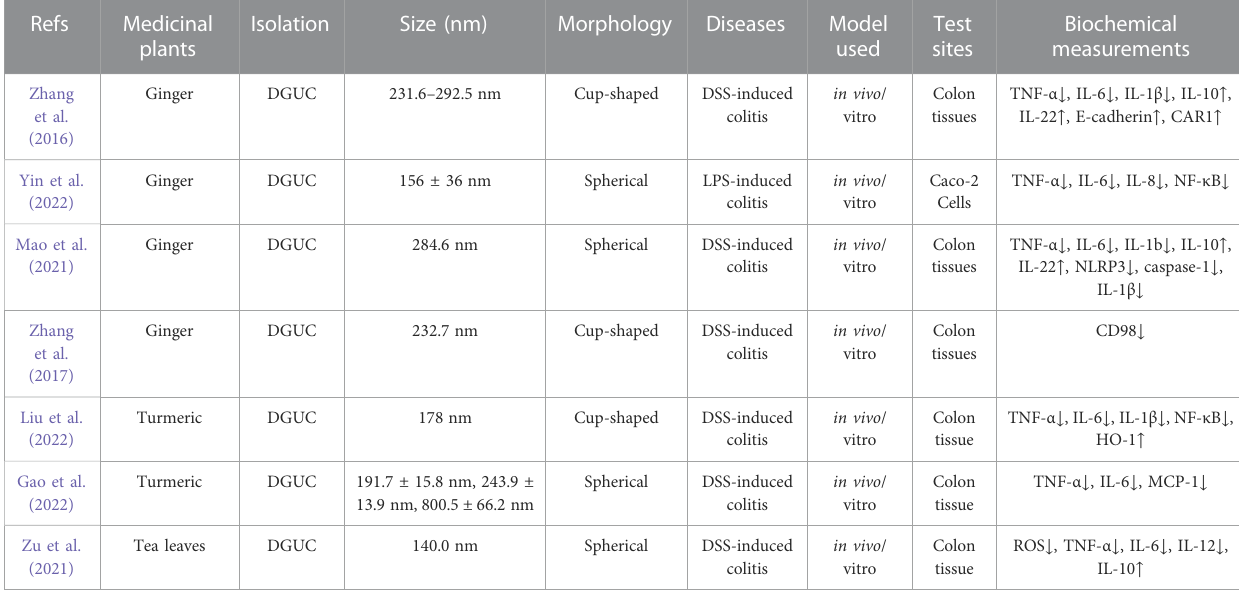
TABLE 2 Extraction, physicochemical characterization and application of EVs derived from medicinal